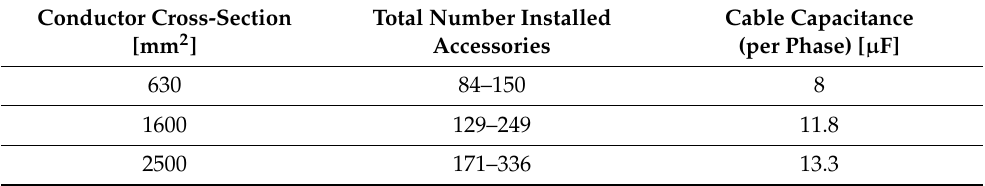
Table 1. Example of cable characteristics of a typical 50 km long 220 kV cable circuit for differ- ent copper conductor cross-sections showing the number of installed cable accessories and cable